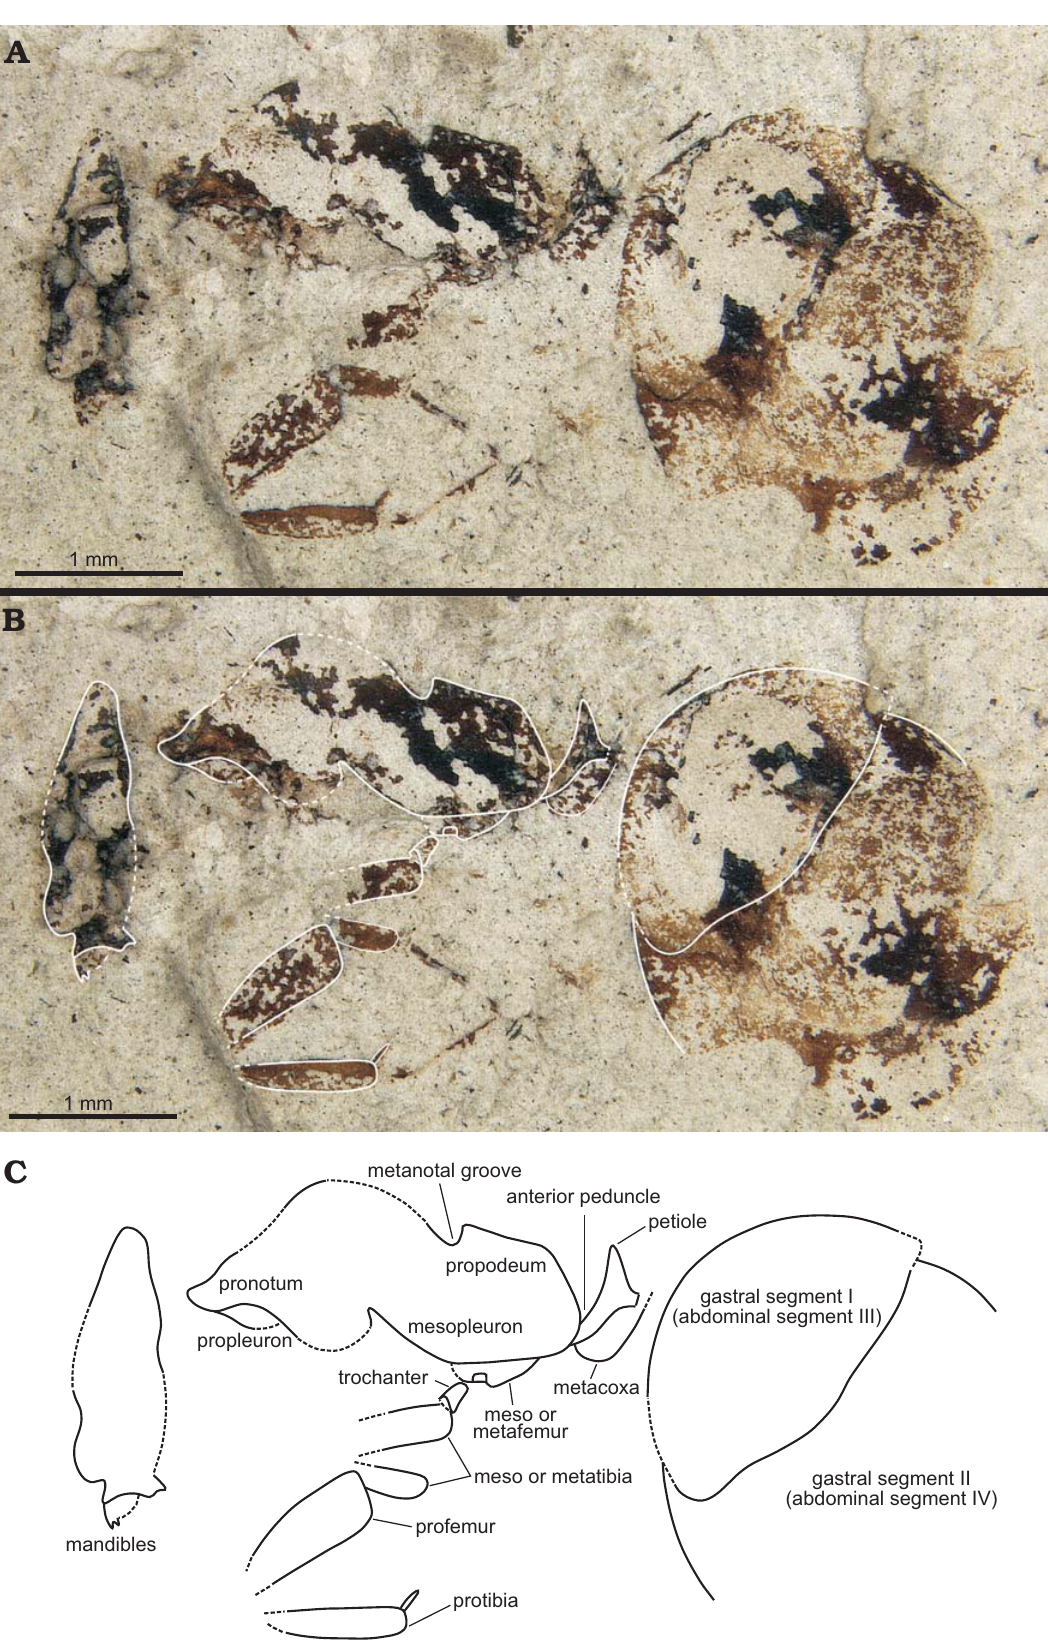
Fig. 2. Aneuretine ant Napakimyrma paskapooensis gen. et sp. nov. (holotype UAIPC 6300) from the Paleocene Paskapoo Formation at Dennis Wighton site 1 of Blackfalds Insect and Plant Site. Automontage generated photographs ( A , B ), line drawing ( C